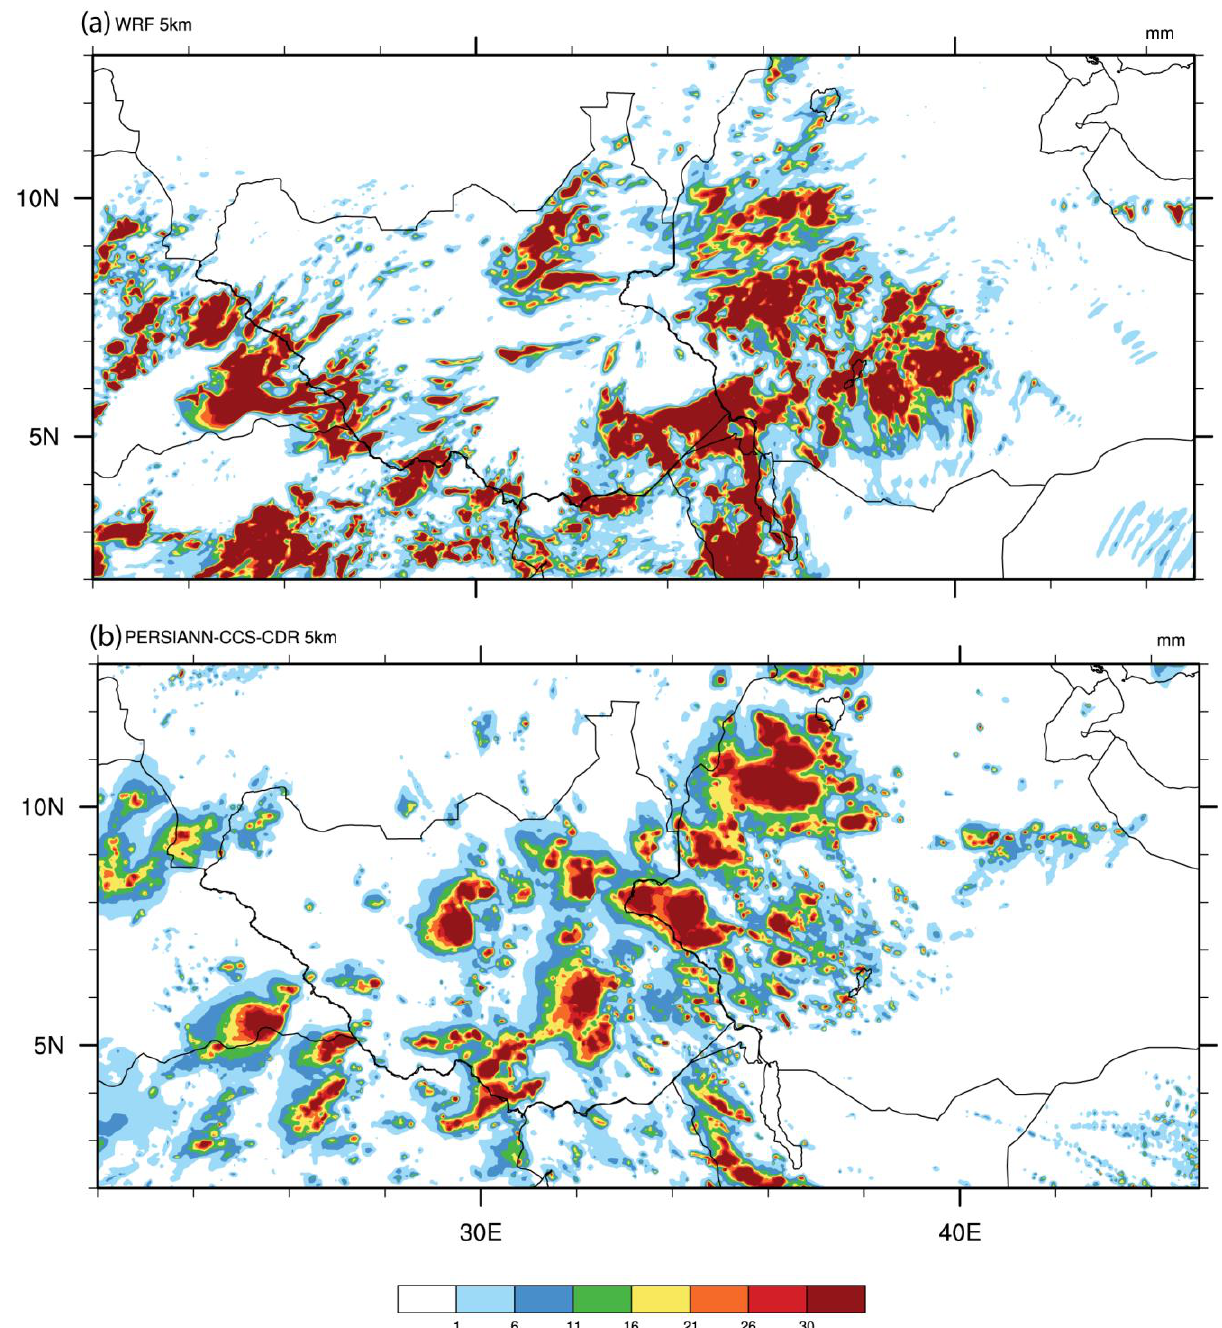
Figure 5. Distribution of simulated and observed precipitation (mm/day) on 8 June 2020 over East Africa. ( a ) WRF; ( b ) PERSIANN-CCS-CDR.